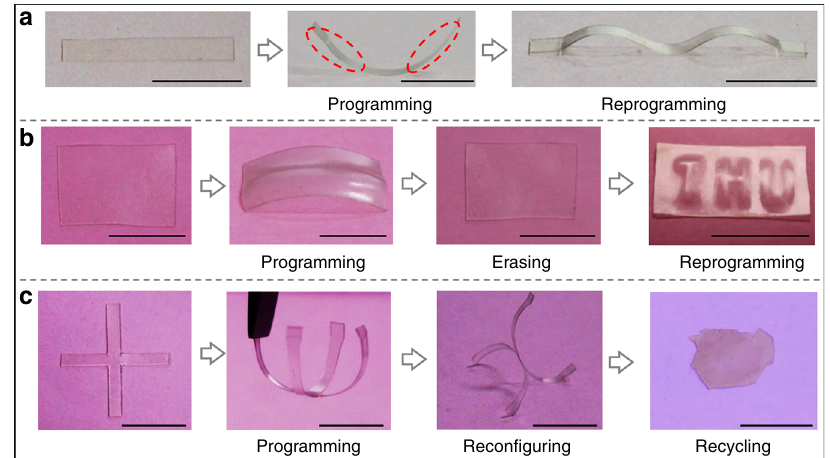
Fig. 5 Solvent-induced reprogramming and recon fi guring of epoxy vitrimer. a Consecutively programming of a vitrimer fi lm. Scale bar: 1 cm. b After erasing the shape of a programmed vitrimer fi lm, reprogramming it by solvent into a different shape. Scale bar: 1 cm. c Solvent triggered programming to a four- petal “ fl ower ” , and then recon fi guring to another 3D shape with two petals up and two petals down. The recon fi gured structure was recycled to a fl at fi lm by heat-molding. Scale bar: 1